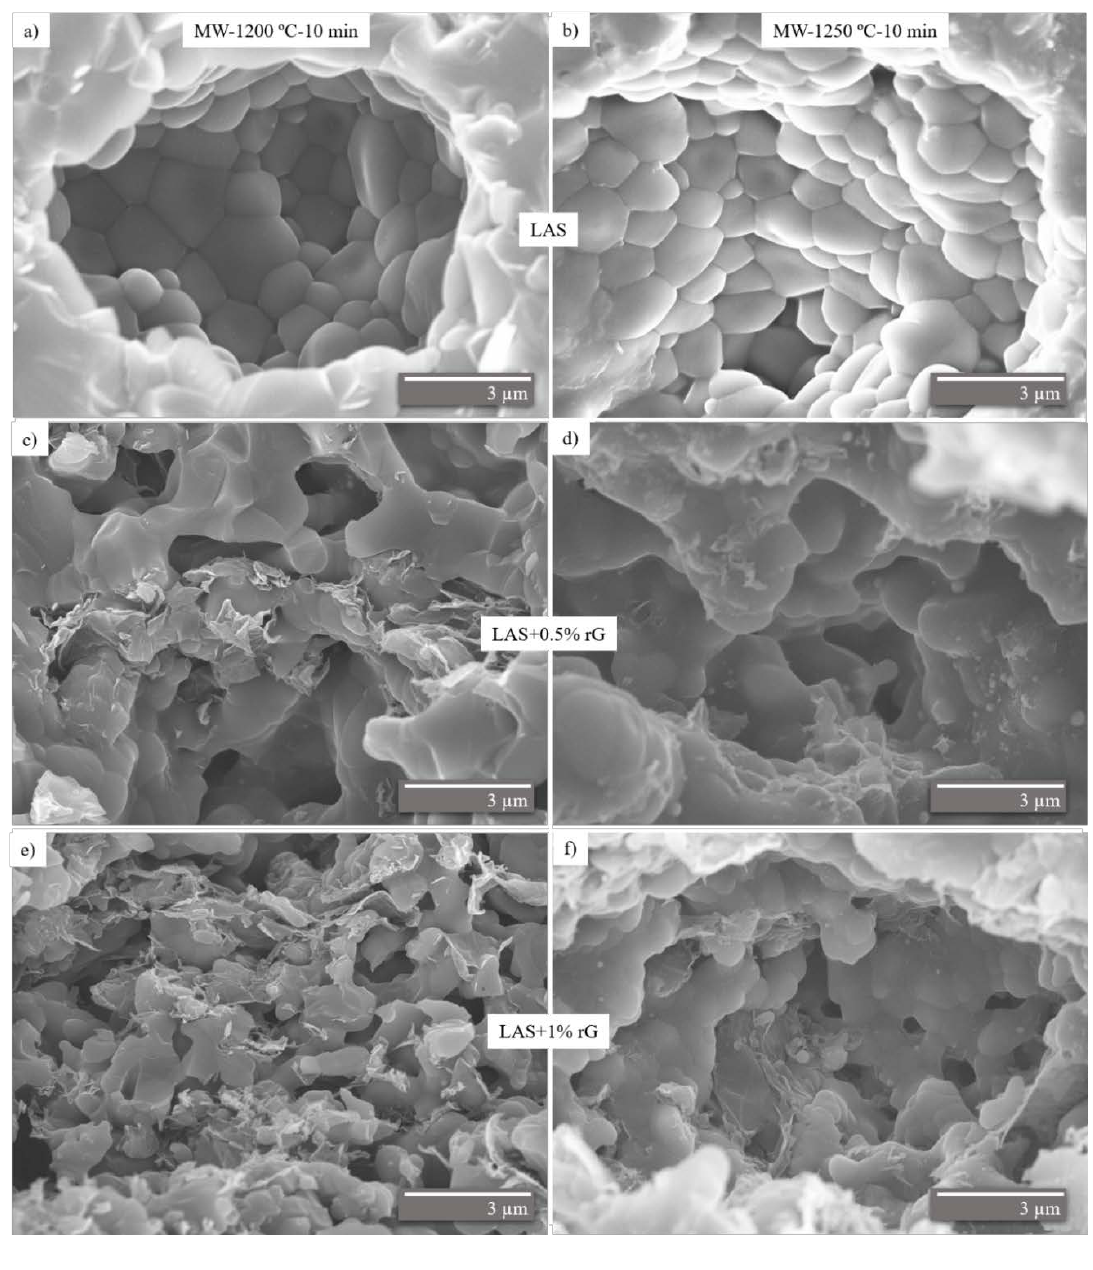
Figure 1. FE-SEM images of the fracture surface of the materials sintered by microwave at 1200 °C ( a , c , e ) and 1250 °C ( b , d , f ).